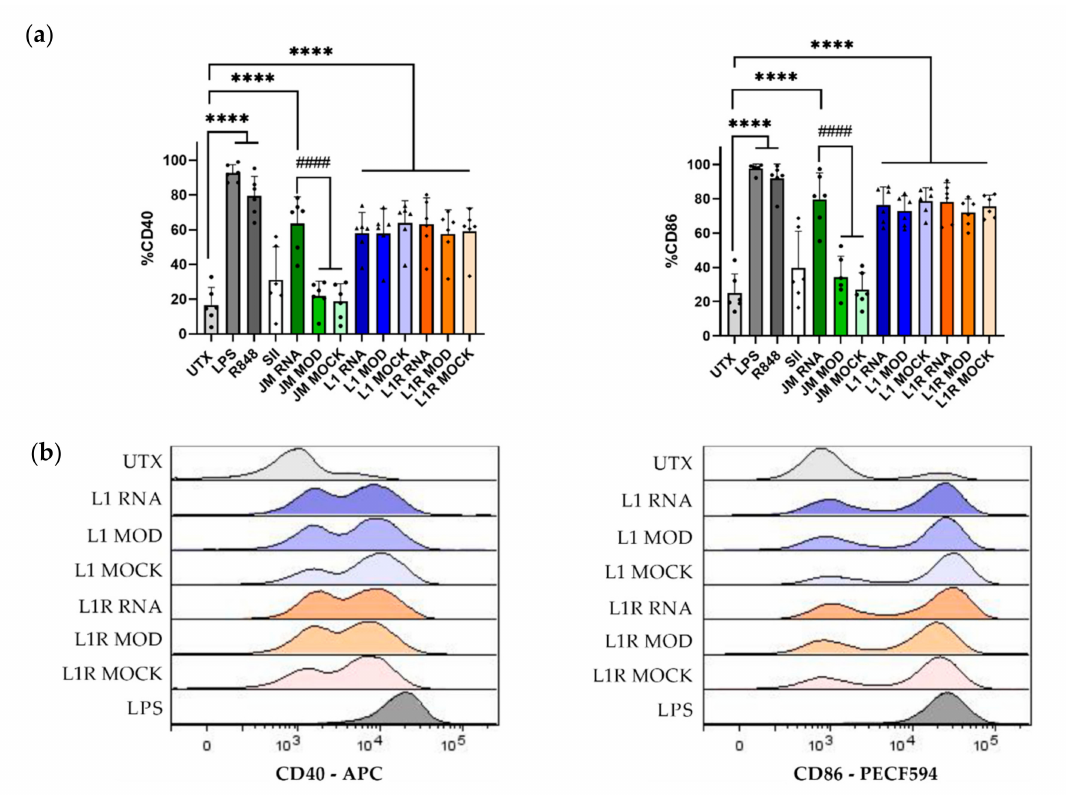
Figure 5. Maturation of bone-marrow-derived CD103 + DCs after transfection with LAH4-L1 (L1)- or LAH4-L1R (L1R)-formulated tOVA mRNA. CD103 + DCs were left untreated (UTX) or transfected on day 13 with mRNA encoding tOVA (unmodified, RNA/modified, MOD), or without mRNA (MOCK). The next day, cells were harvested and stained for DC markers and the maturation markers CD86 and CD40. Percentage CD40 and CD86 expression within the CD11c + CD103 + DCs ( a ); cells were treated with LPS or R848 as a positive control; positive control for transfection was performed with jetMessenger ® (JM); positive control for antigen presentation where DCs were pulsed with SIINFEKL (SII). Overlay graphs for CD40 and CD86 expression ( b ); one representative result. n = 6; each dot represents one replicate, mean ± SD. One-way ANOVA, Tukey’s multiple comparison test: **** p < 0.0001 compared to the untreated cells; #### p < 0.0001 compared to jetMessenger ®